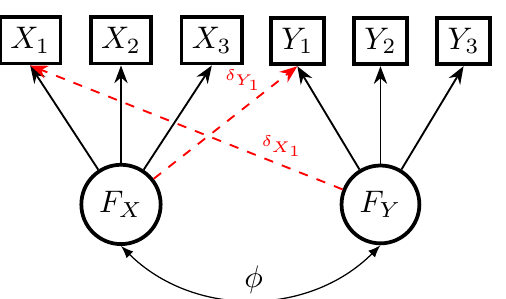
Figure 4. Simulation Study 2: Data-generating model. Cross loadings are displayed with dashed red